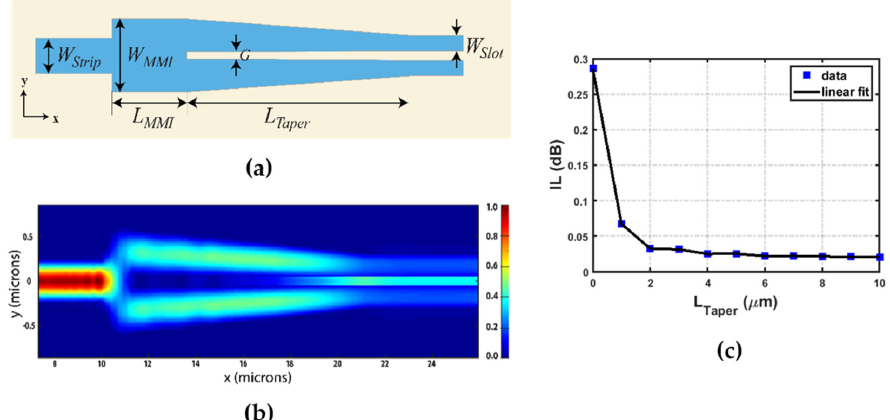
Figure 3. ( a ) Schematic of the mode converter; ( b ) quasi-TE-mode profile of the mode converter as depicted from FDTD solver; ( c ) the insertion loss of the mode converter as a function of the length of its taper section at λ = 1.55 µm.